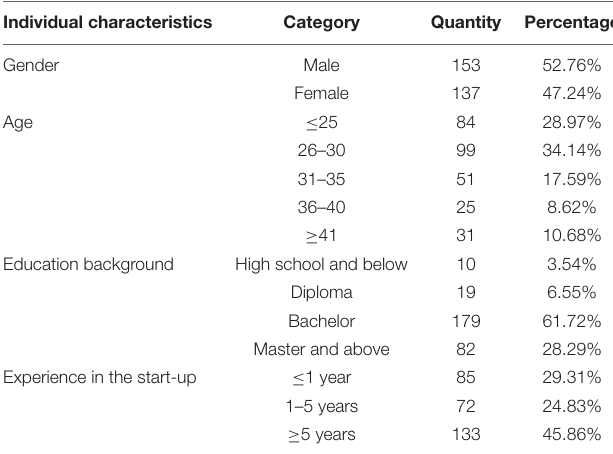
TABLE 1 | Sample description ( N =